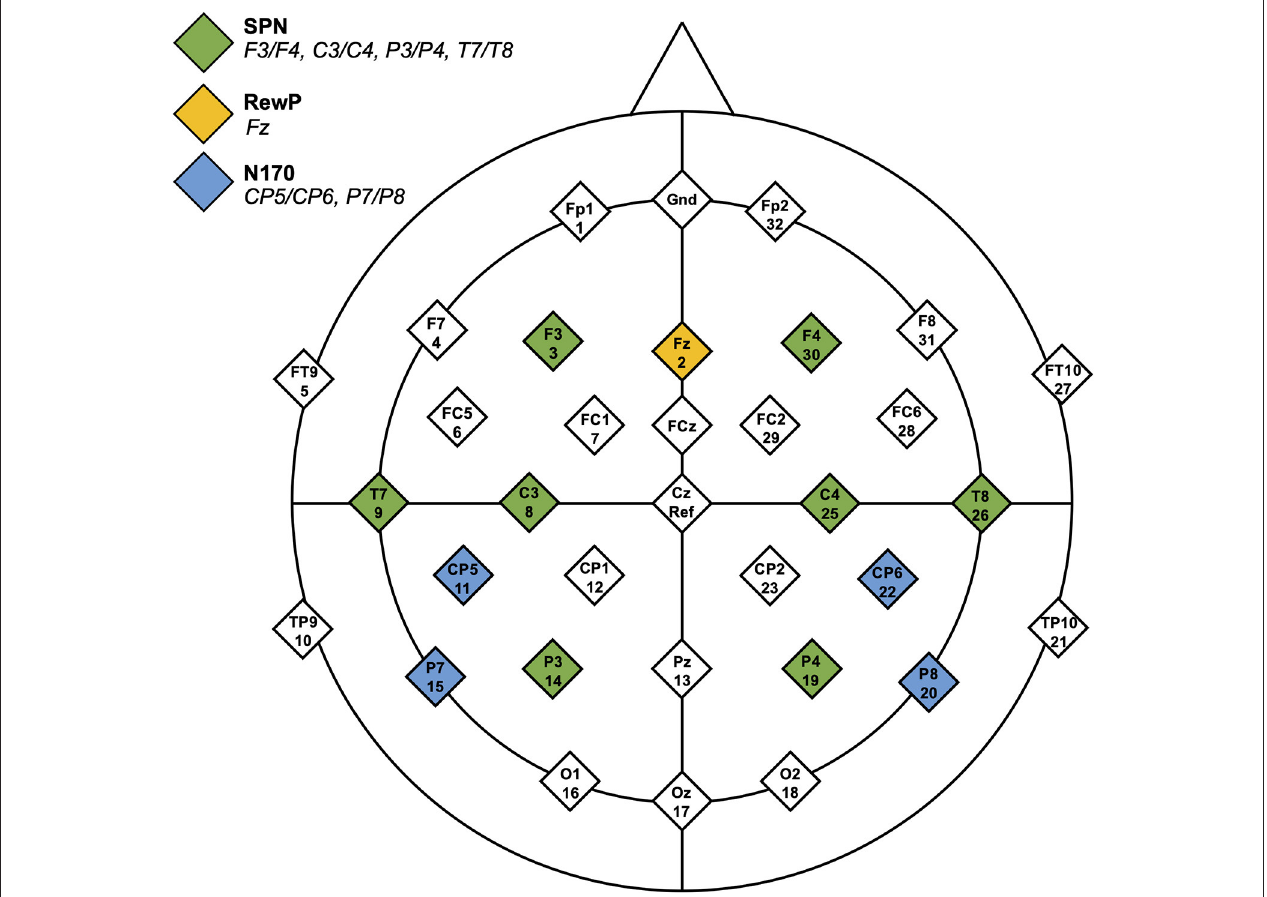
FIGURE 2 | Headmap of electrode positions displaying regions of interest for the SPN, RewP, and N170